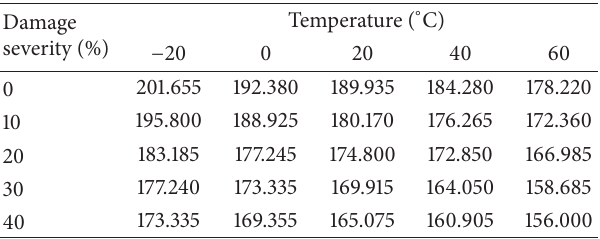
Table 6: The first order natural frequencies under coupling effect of temperature and damage